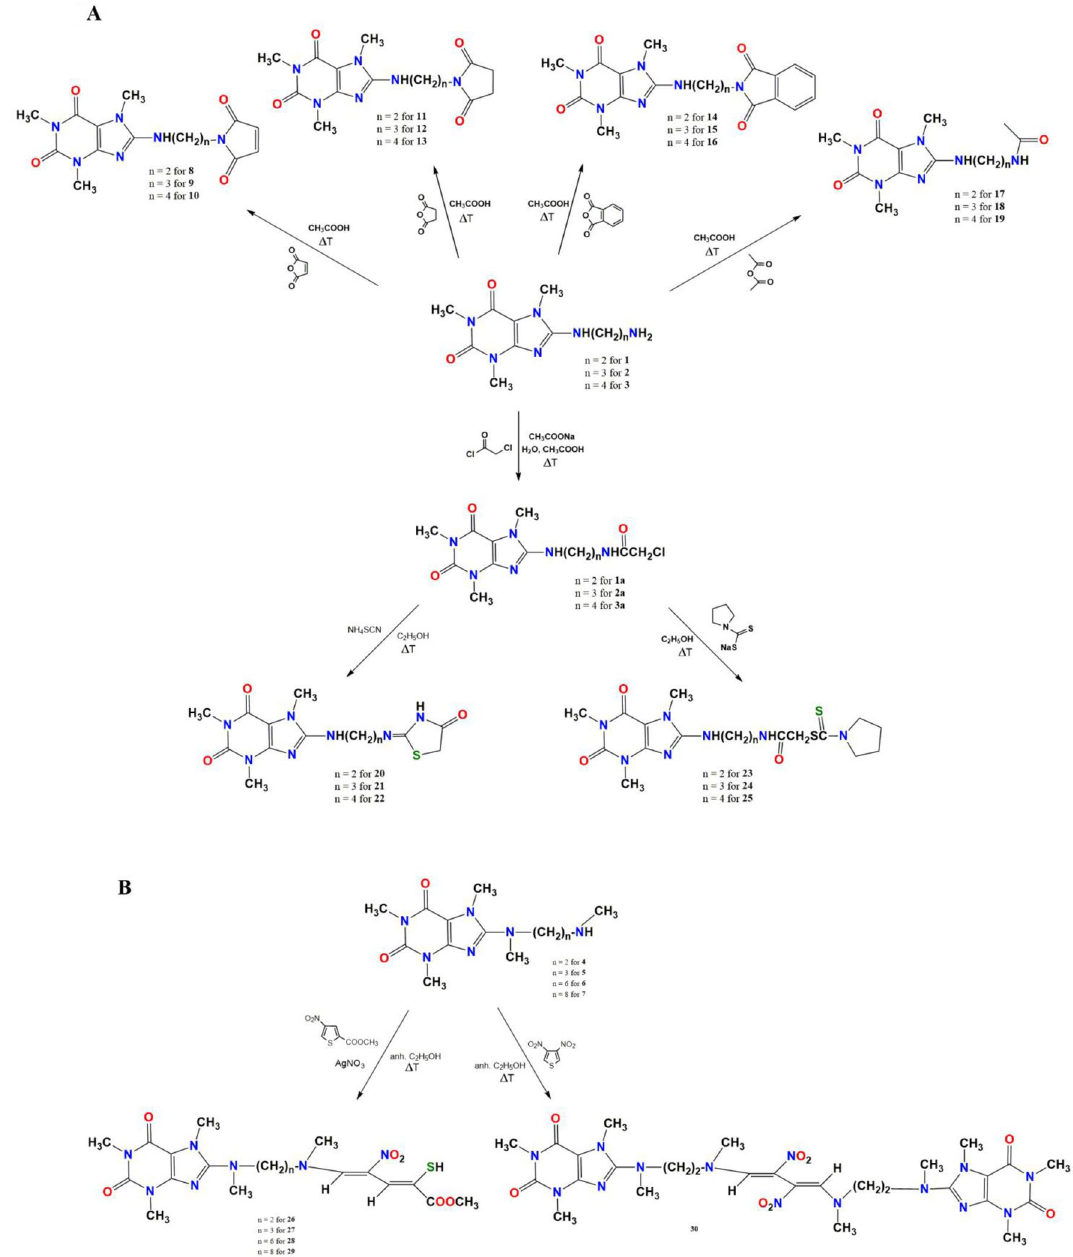
Figure 1. Synthesis of caffeine derivatives 2–25 ( A ) and 26–30 ( B